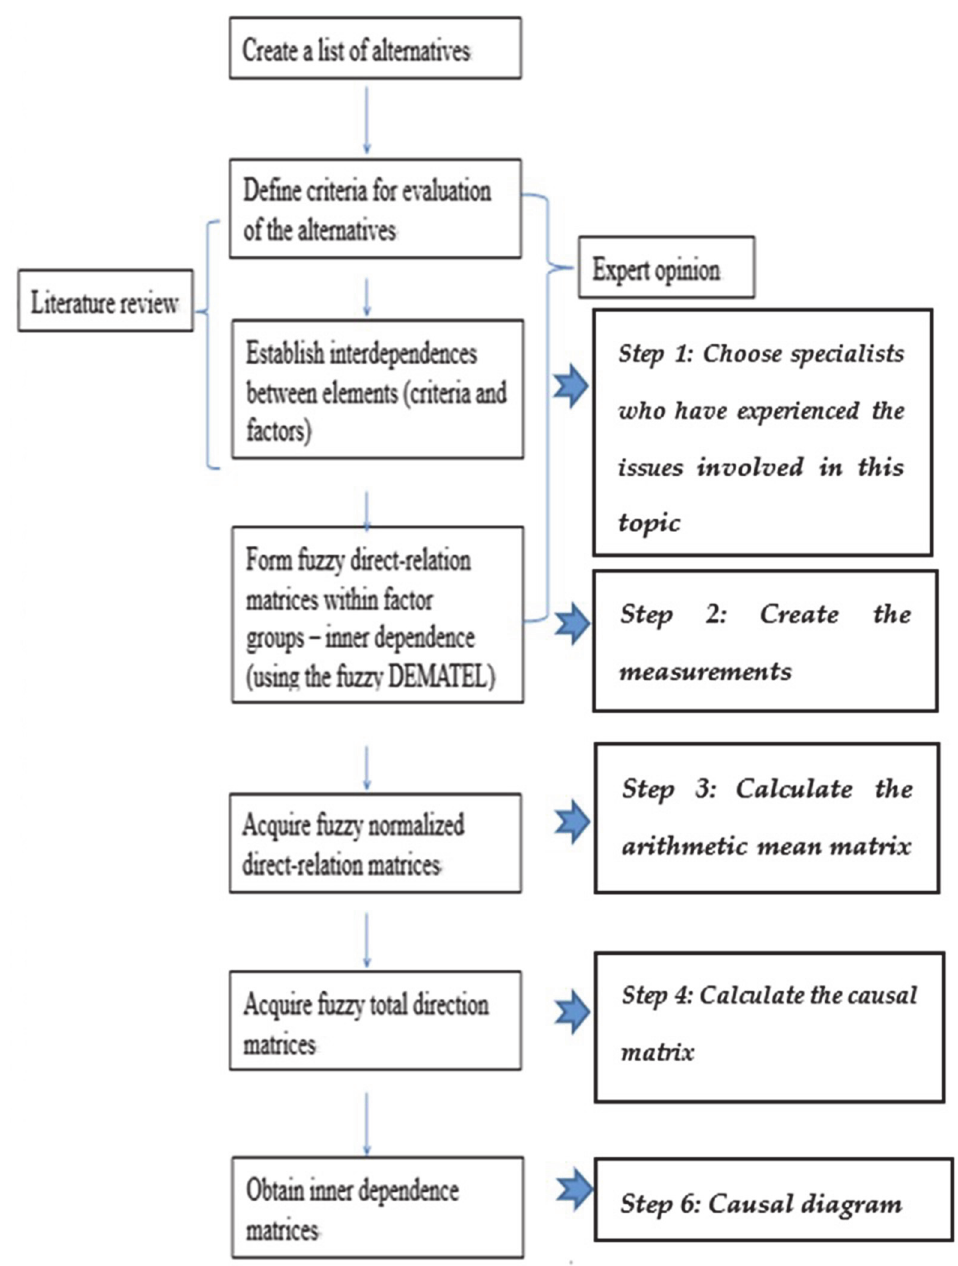
Figure 2. The structure and method of the fuzzy DEMATEL. We obtained four dimensions and twelve criteria suitable for evaluating a wealth management bank [85,86]. The DEMATEL analysis steps were based on the research of Chou et al. [87] and Chiang and Birtch [86], among others. The analysis process was divided into six